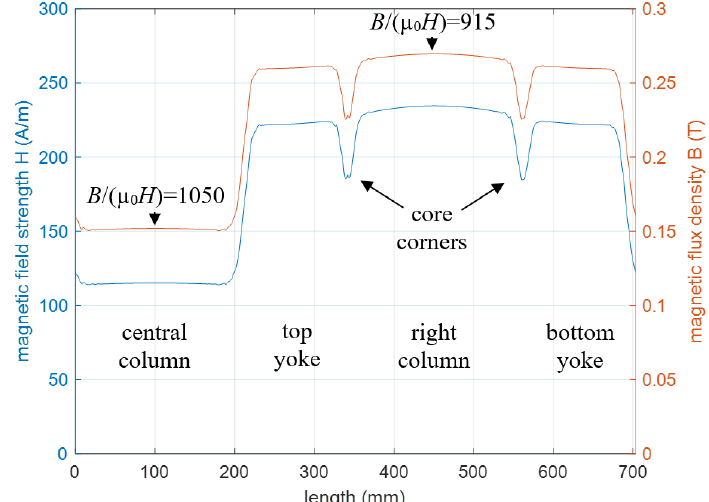
Figure 12. Magnetic field strength H and magnetic flux density B along the path in the centre of the core passing through the central column, top yoke, right column, and bottom yoke; the values of static permeability B /( µ 0 H ) are presented.